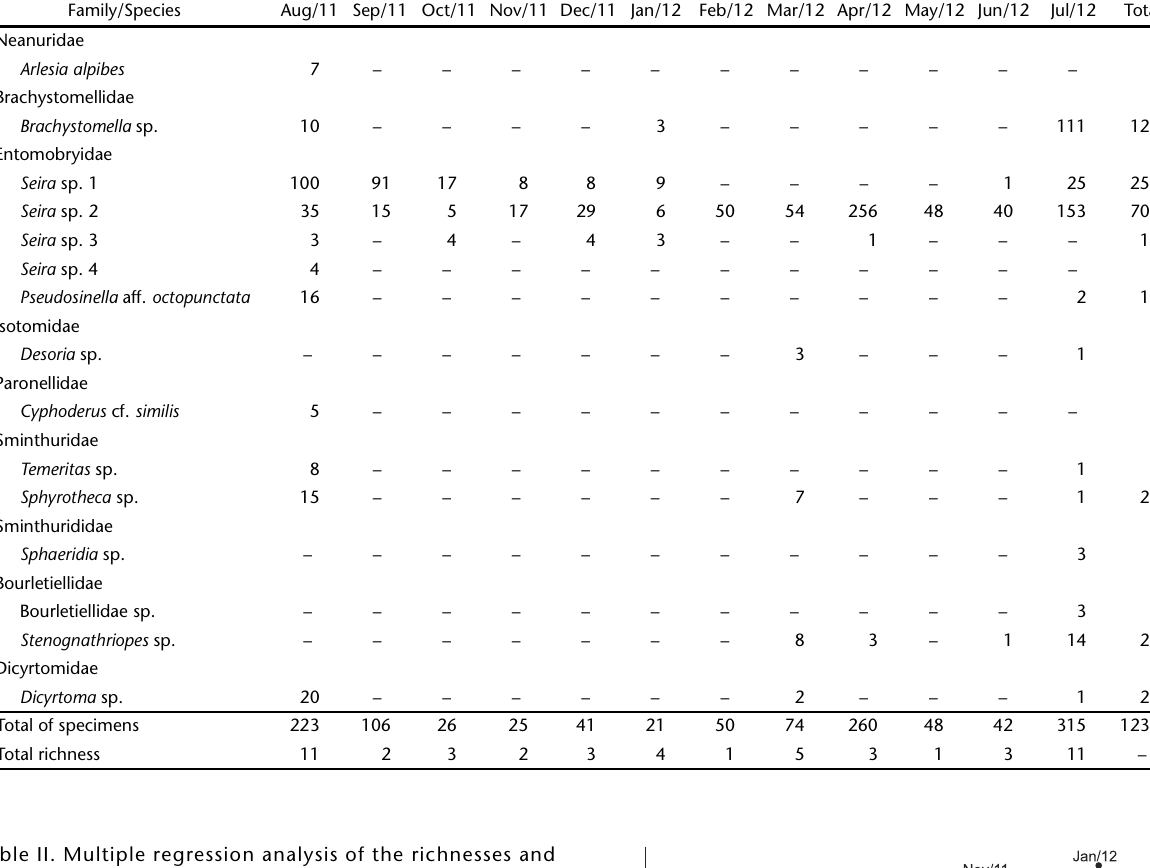
Table II. Multiple regression analysis of the richnesses and abundances of Collembola species captured in João Câmara, RN, with climatic variables. Regressions at the species level were only performed for species encountered during at least five months. Climatic Variables Collembola R 2 F-value P-value adj Precipitation T. max T. min